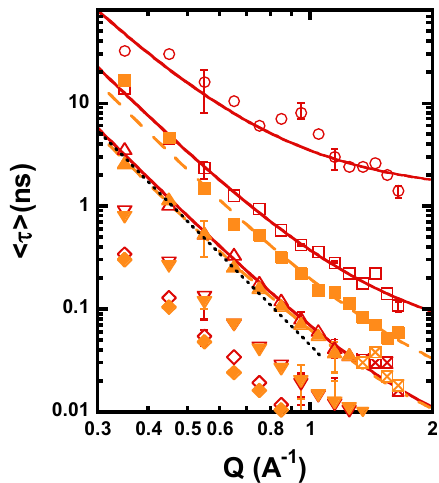
Fig. 6. Average time for H motions obtained for EPrec (unfilled) and ePrec (filled) samples at 250 K (circle), 290 K (square), 320 K (up-triangle), 360 K (down-triangle) and 400 K (diamond), imposing β = 0.5. Lines are fits of Eq. 2 to EPrec (solid lines) and ePrec (dashed lines). The dotted line shows the low-Q Gaussian behavior for the 320 K data. Error bars have been included at selected Q-values (0.55, 0.95, 1.15 and 1.65 ). Results at 320 K and high Q-values represented by Å (cid:6)(cid:7) crossed squares are subject to very large uncertainties and were not considered in the fit.